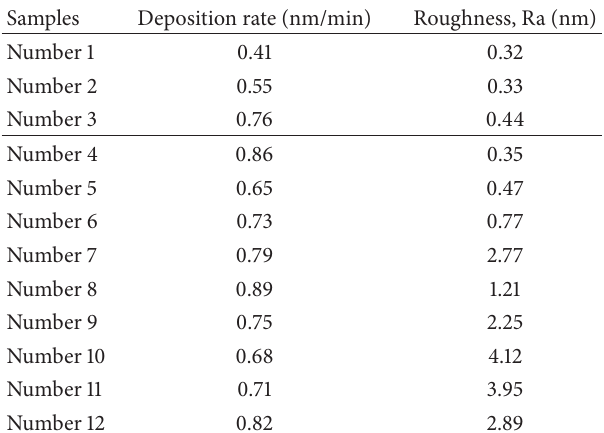
Table 2: The deposition rate and roughness value for the TiO